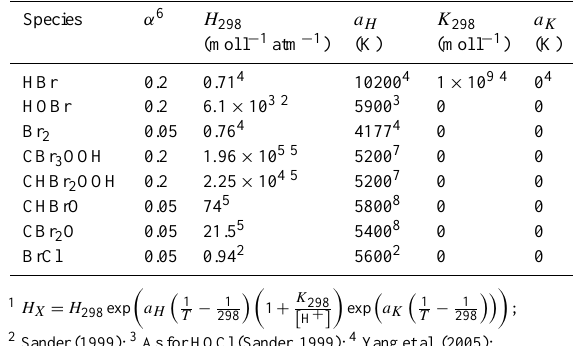
of bromine species X